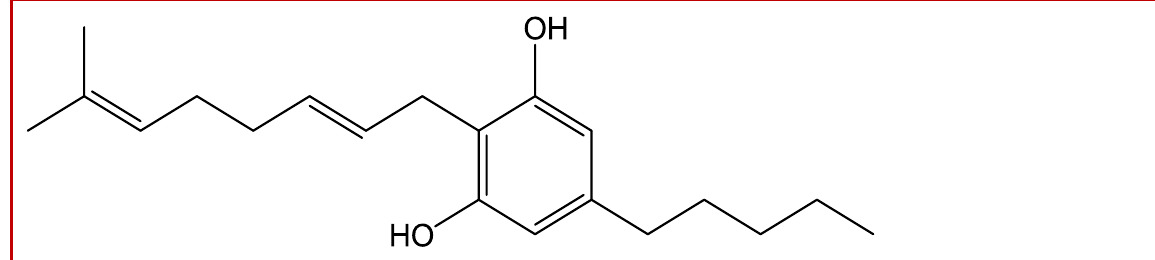
Figure 1: Chemical structure of cannabigerol